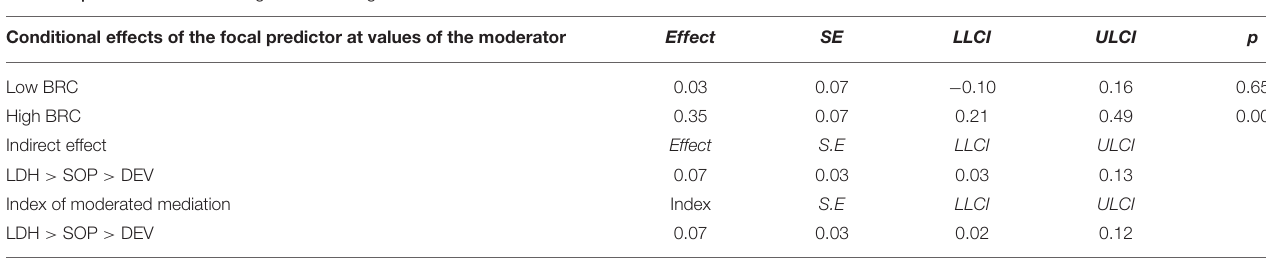
TABLE 4 | Conditional moderating and mediating effect. Conditional effects of the focal predictor at values of the